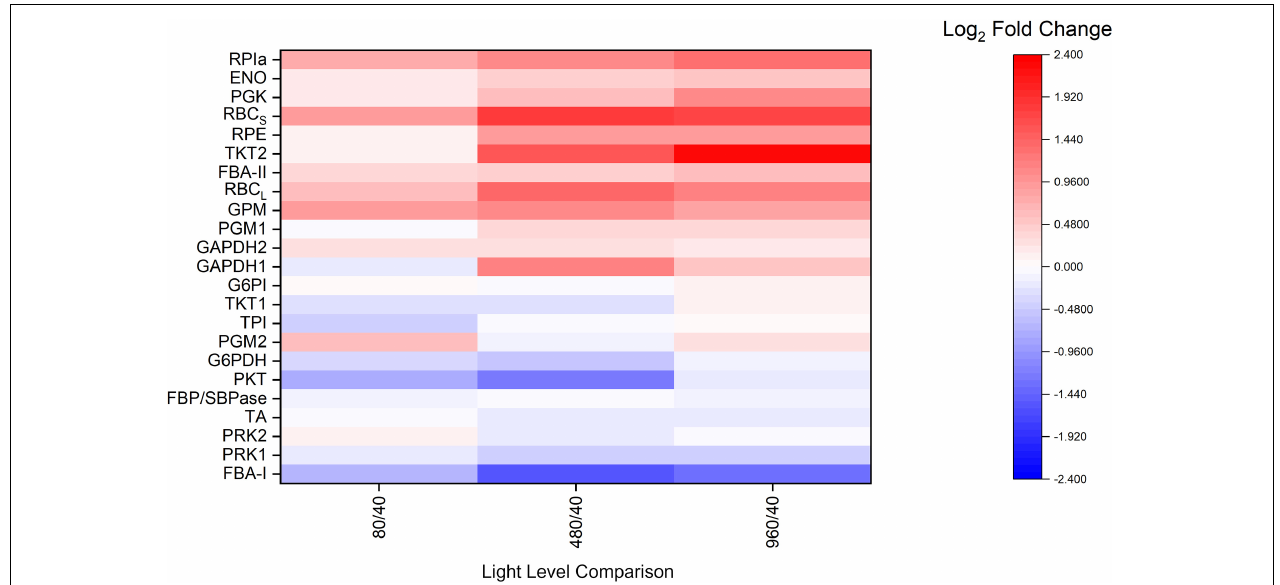
FIGURE 2 | Average proteomic fold-change results relative to the 40 µ mol m − 2 s − 1 condition for selected central carbon metabolism related enzymes, n = 3 for each light condition. ENO, enolase; FBA-I/II, fructose-bisphosphate aldolase class I/II; FBP/SBPase, D-fructose 1,6-bisphosphatase class 2/sedoheptulose 1,7-bisphosphatase; G6PDH, glucose-6-phosphate 1-dehydrogenase; G6PI, glucose-6-phosphate isomerase; GAPDH, glyceraldehyde 3-phosphate dehydrogenase; GPM, phosphoglucomutase; PGK, phosphoglycerate kinase; PGM, phosphoglycerate mutase; PKT, phosphoketolase; PRK, phosphoribulokinase; RBCl, ribulose bisphosphate carboxylase large chain; RBCs, ribulose bisphosphate carboxylase small subunit; RPE, ribulose-phosphate 3-epimerase; RPIa, Ribose-5-phosphate isomerase A; TA, transaldolase; TKT, transketolase; TPI, triose-phosphate isomerase. For isozymes, refer to NCBI accession numbers: GAPDH1 (CAA60134.1), GAPDH2 (CAA60135.1), PRK1 (P37101.1), PRK2 (WP_010873279.1), TKT1 (WP_010871940.1), TKT2 (WP_010874098.1), PGM1 (WP_010871279.1), and PGM2